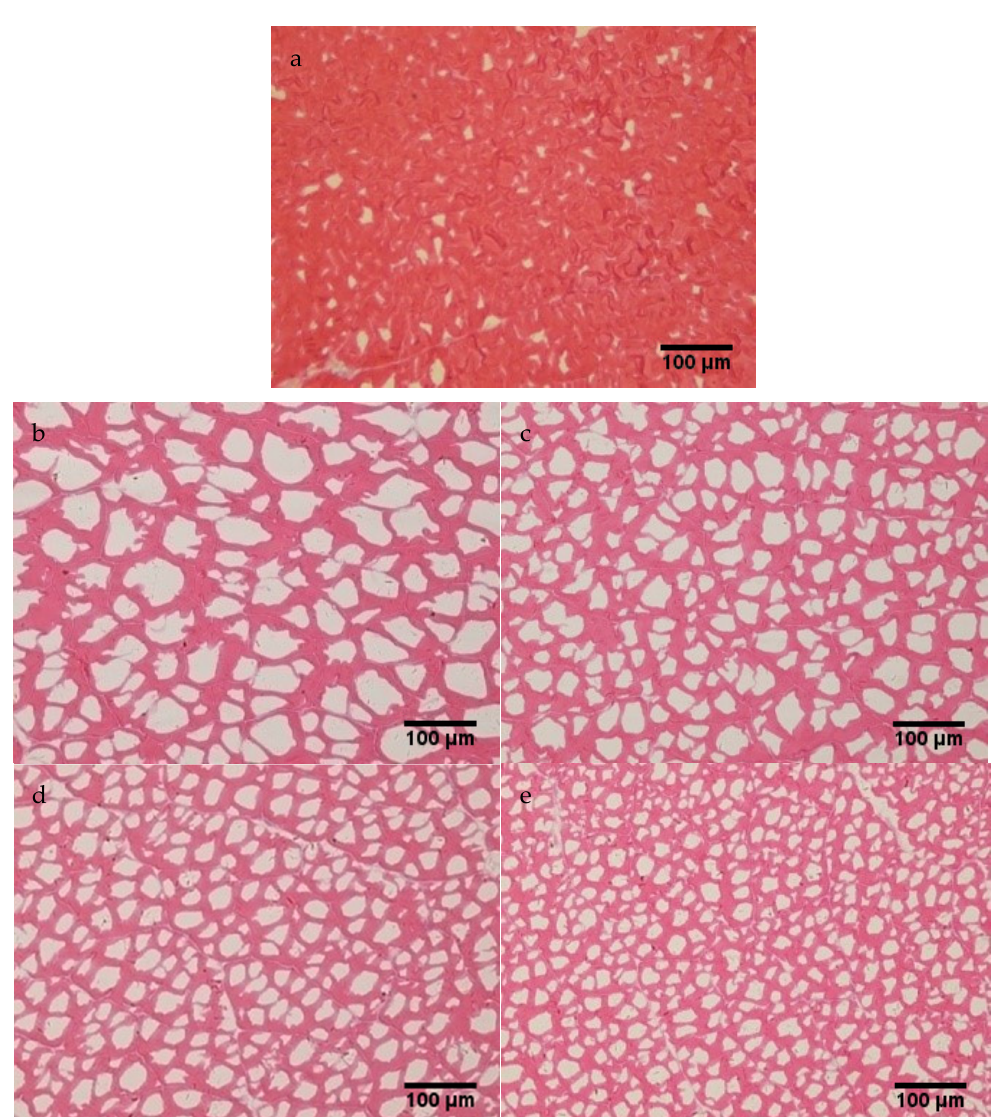
Figure 2. Micrograph images of transversal cuts of muscle samples treated under different freezing